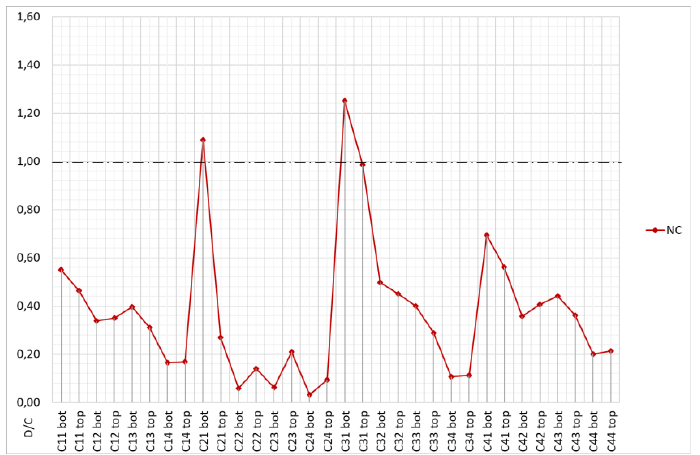
Buildings 2022 , 12 , x FOR PEER REVIEW Figure 10. DCM: NC chord rotation 𝐷 𝐶⁄ ratios on columns (pushover analysis). Figure 10. DCM: NC chord rotation D / C ratios on columns (pushover analysis).